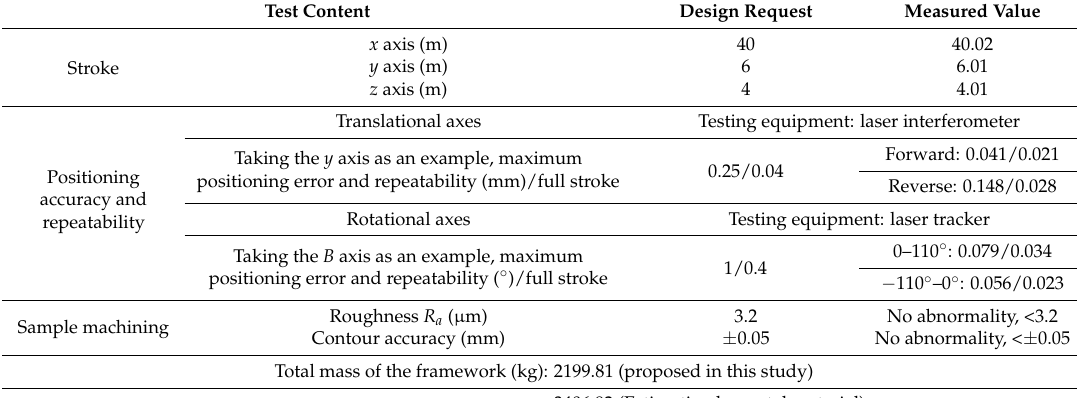
Table 8. Inspection results of the L5AMC prototype related to the